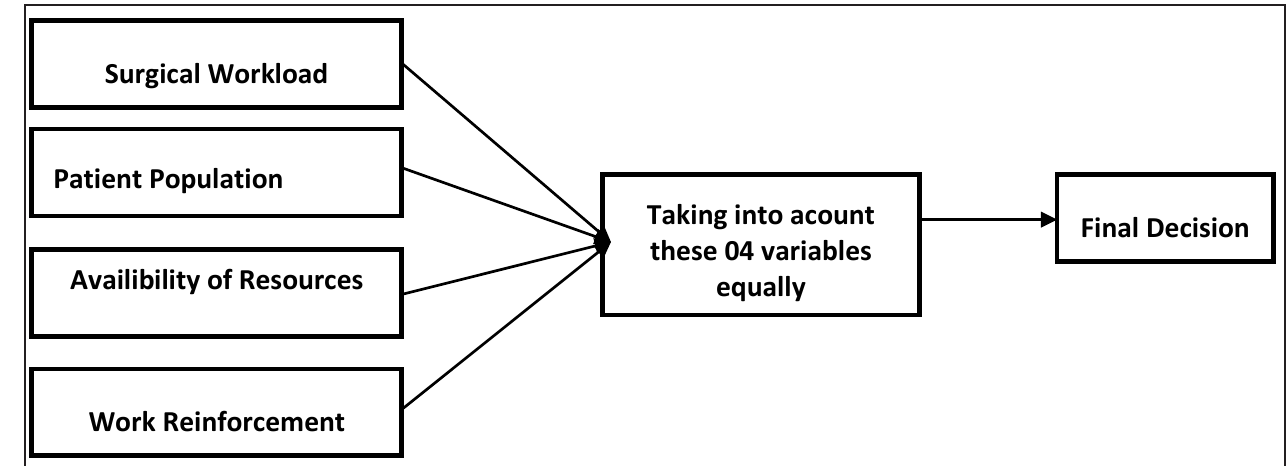
Figure-I. Essential variables to plan elective surgeries during & after COVID-19